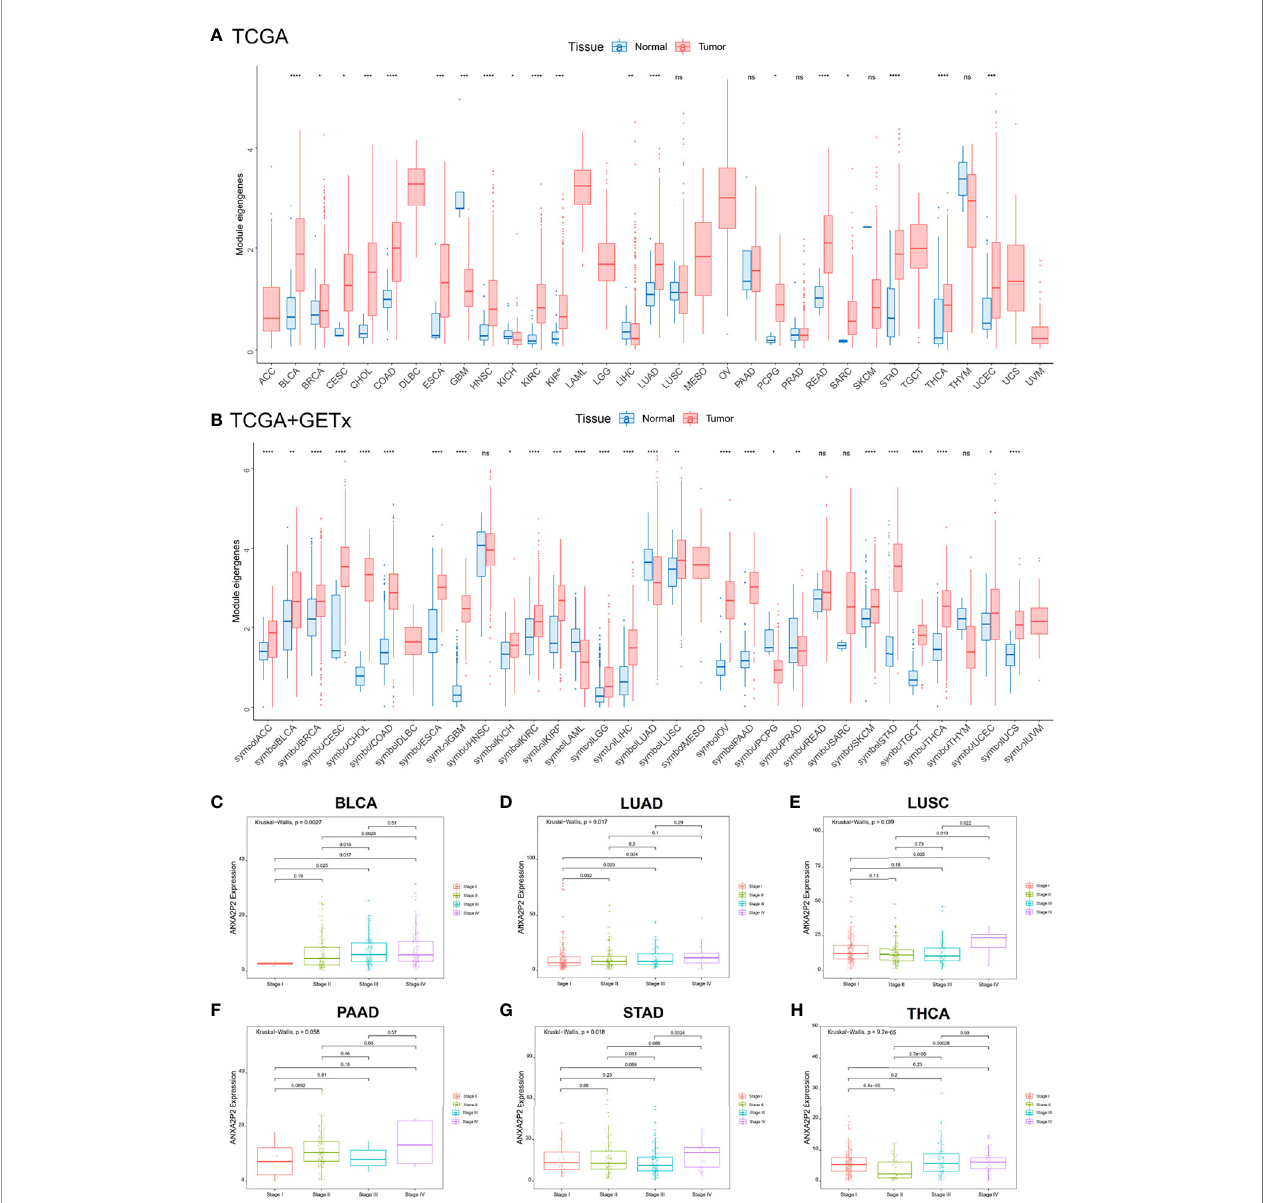
FIGURE 1 | Differential transcriptional expression of ANXA2P2 and its correlation to tumor stages in pan-carcinoma. (A) The landscape of ANXA2P2 expression levels based on TCGA dataset. *P < 0.05, **P < 0,01, ***P < 0.001, ****P < 0.0001 and ns indicated no signi fi cant. (B) The landscape of ANXA2P2 expression levels based on TCGA and GTEx datasets; red represents tumor tissue, and blue represents normal tissue. Correlations between ANXA2P2 expression and tumor stages in (C) BLCA, (D) LUAD, (E) LUSC, (F) PAAD, (G) STAD, and (H)